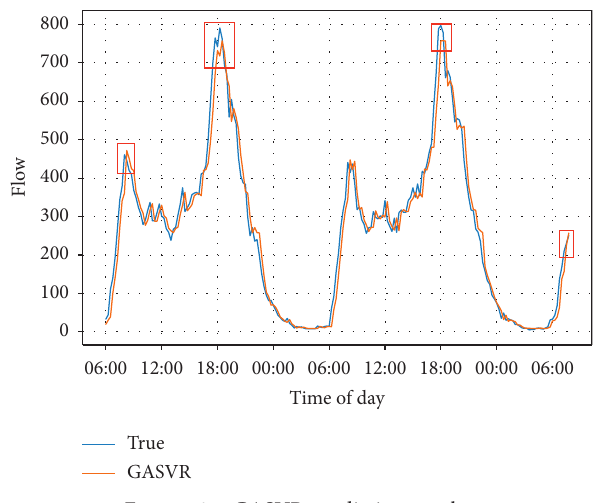
Figure 25: GASVR prediction results.